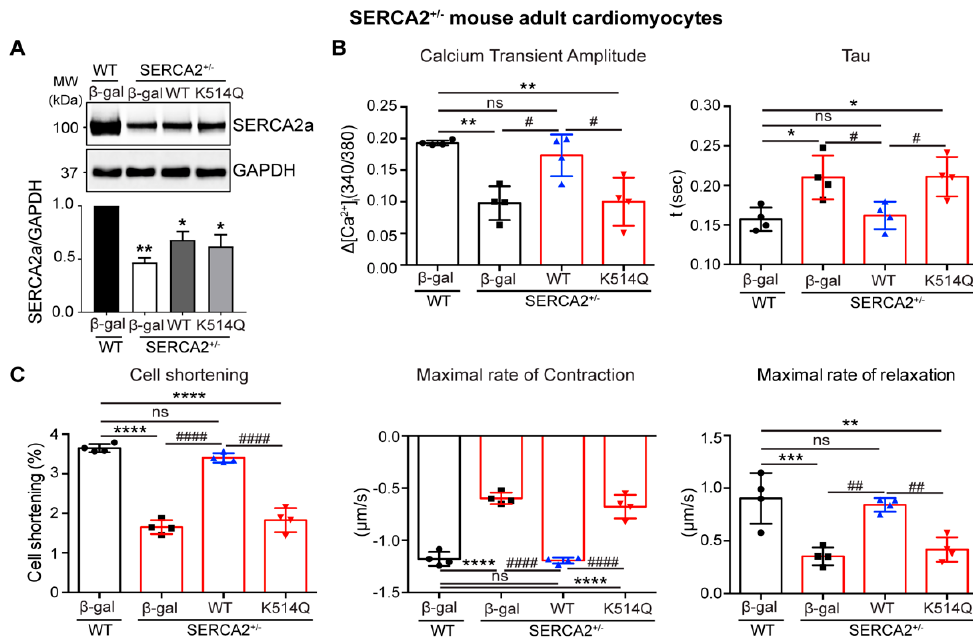
Figure 6. Acetylation on Lys514 of SERCA2a impairs cardiomyocyte function. ( A ) Immunoblot shows levels of SERCA2a in cardiomyocytes isolated from wild-type (WT) and SERCA2 heterozygous knock- down mice (SERCA2 +/ − ) infected with respective adenoviruses. ( B ) Calcium transient summary show- ing calcium transient amplitude and tau values. ( C ) Adult cardiomyocyte contractility data show peak shortening, maximal rate of relaxation, and maximal rate of contraction values. The function of ACMs was assessed using a video-based edge-detection system (IonOptix, Inc, Milton, MA) 24 h after infec- tion of ACMs with adenovirus (50 MOI of each virus). n = 4. Graphs show means ± SD, with each data point represented by a mean average of 15 ACMs isolated from one heart sample. ns, not significant; * p < 0.05; ** p < 0.01; *** p < 0.001; **** p < 0.0001 vs. WT + β -gal and # p < 0.05; ## p < 0.01; #### p < 0.0001 vs. SERCA2 +/ − + WT SERCA2a by one-way ANOVA. 3. Discussion In this study, we confirmed that p300 directly interacts with SERCA2a and acetylates its multiple lysine residues. We observed that protein and mRNA levels of p300 are signifi- cantly increased in human HF. A total of 12 putative lysines of SERCA2a acetylated by p300 were identified from in vitro acetylation assay combined with LC-MS/MS analysis. Through biochemical characterization of the identified acetylated lysine sites of SERCA2a using ace- tyl-mimicking mutants, we found that K514 is critical in modulating SERCA2a activity. This finding was further corroborated by mechanical characterization after reintroducing the K514Q mutant of SERCA2a in SERCA2a deficient ACMs. These experiments clearly demon- strated that the K514 acetylation of SERCA2a by p300 hinders normal calcium transients and cardiomyocyte contractility. The more than 300 currently identified PTMs provide great scope for subtle or dramatic alteration of protein structure and function. PTMs modulate a protein’s activity or intracel- lular localization of substrates by blocking a binding site, creating an additional binding site, or conformational change. It leads to changes in multiple physiological functions. PTMs are predominantly triggered by enzymes, and the enzymes responsible are thus attractive tar- gets for therapeutic interventions. The heart has a high metabolic rate requiring rapid adap- tation to new environments and is also sensitive to oxidative stress. In this context, it is not